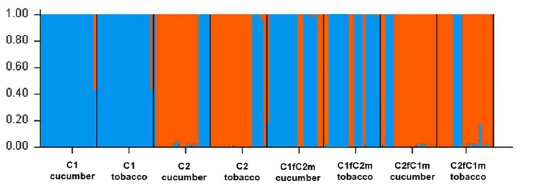
Fig 1. Scatter plot of STRUCTURE results reporting proportional each treatment of B . tabaci . Each treatment is represented by a vertical line with different colors representing probabilities assigned to each of the genetic clusters. Cluster 1 and Cluster 2 are shown in blue and orange, respectively.